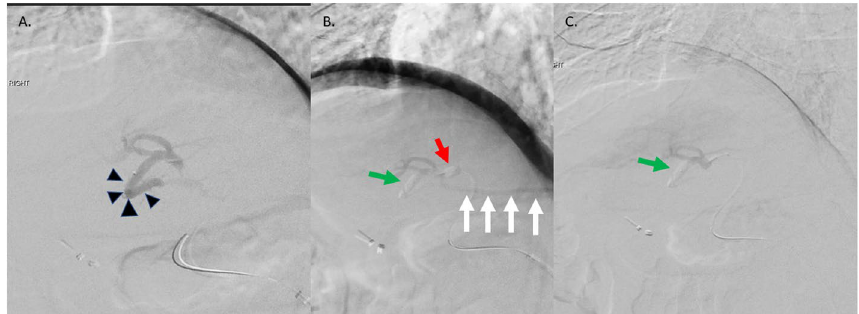
Fig. 4 a-c Variation of DBT with unexpected flow redistribution. a An angiogram from the left hepatic artery demonstrated contributing vessels to target lesion in segment 4 with adjacent origin of the segment 3 arteries (black arrow head). b A Sniper microcatheter was placed in to the segment 3 arteries and balloon inflated to protect segment 3 parenchyma (green arrow), and a second microcatheter placed proximal to direct flow into feeding branches (red arrow). However, flow to segment 2 was identified (white arrows). c Interestingly, when the proximal balloon was deflated, less flow was noted to segment 2, so this area was treated with only distal occlusion